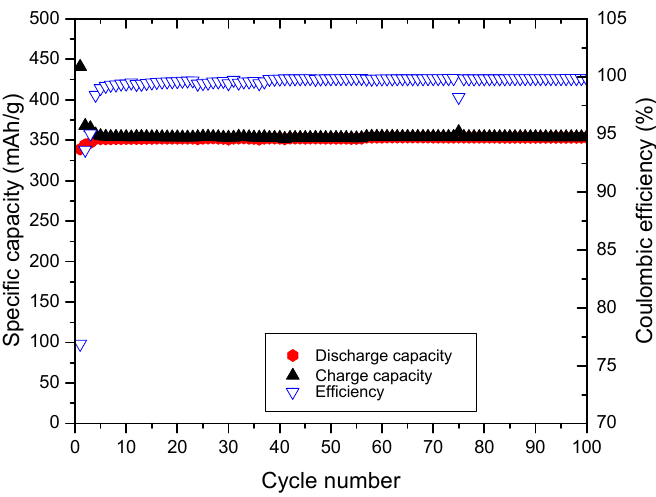
Figure 7. Cycling profile of graphite/Li cell containing 1 M LiPF 6 in EMS:EA (1:1) + 4% FEC electrolyte, in the potential range from 0.02 to 1.5 V vs. Li/Li + .